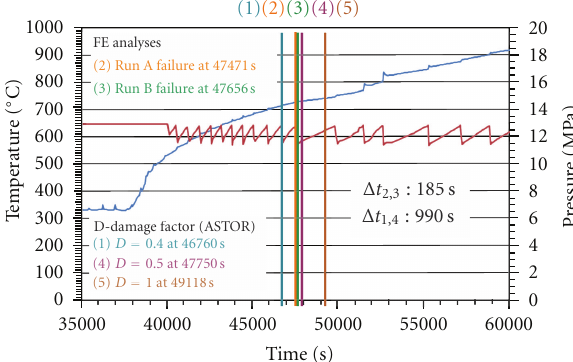
Figure 13: Failure times and load progression.